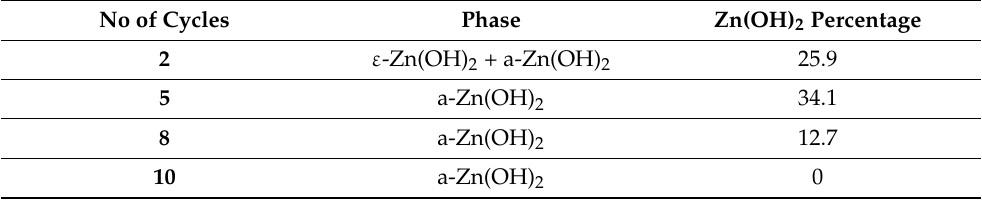
Table 2. Weight percentage of Zn(OH)2 in ZnO milled powders calculated from TGA.